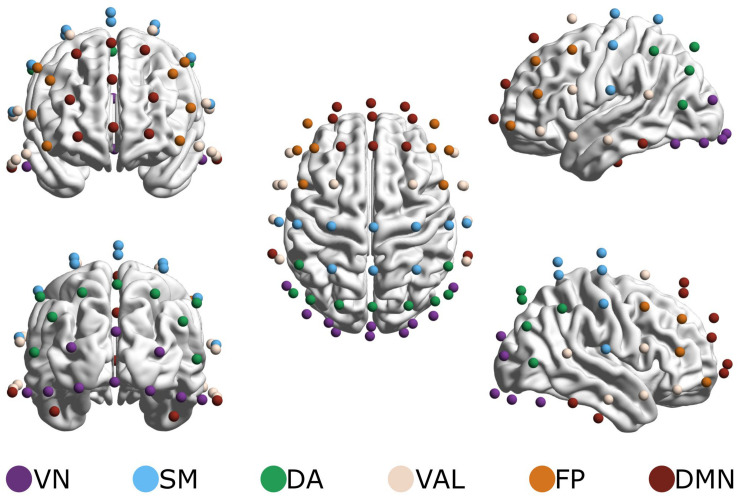
Resting-state networks (RSNs). Electrodes were grouped to represent six RSNs: the visual network (VN, 10 channels), the somatomotor network (SM, 10 channels), the dorsal attention network (DA, 9 channels), the combined ventral attention and limbic networks (VAL, 12 channels), the frontoparietal network (FP, 8 channels) and the default mode network (DMN, 13 channels). Brain maps were created using the BrainNet Viewer software (Xia et al., 2013) after electrode positions were transformed to match a template head using SPM 12b (Penny et al., 2007). The figure originally appeared in Racz et al. (2019).